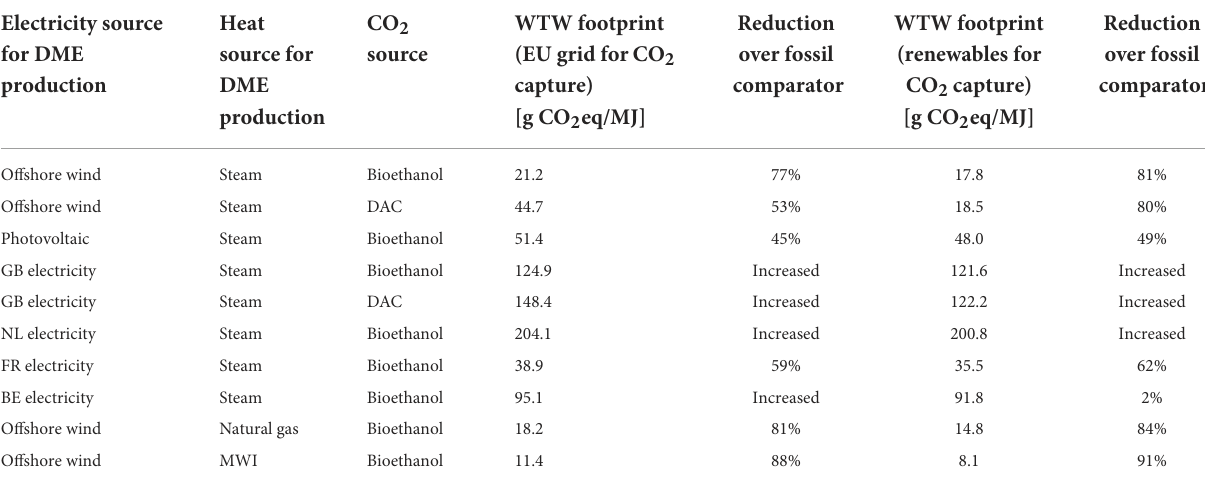
TABLE 2 The Power-to-X DME well-to-wheel or cradle-to-grave carbon footprints when DME is produced using different sources of electricity, heat and CO 2 . Electricity